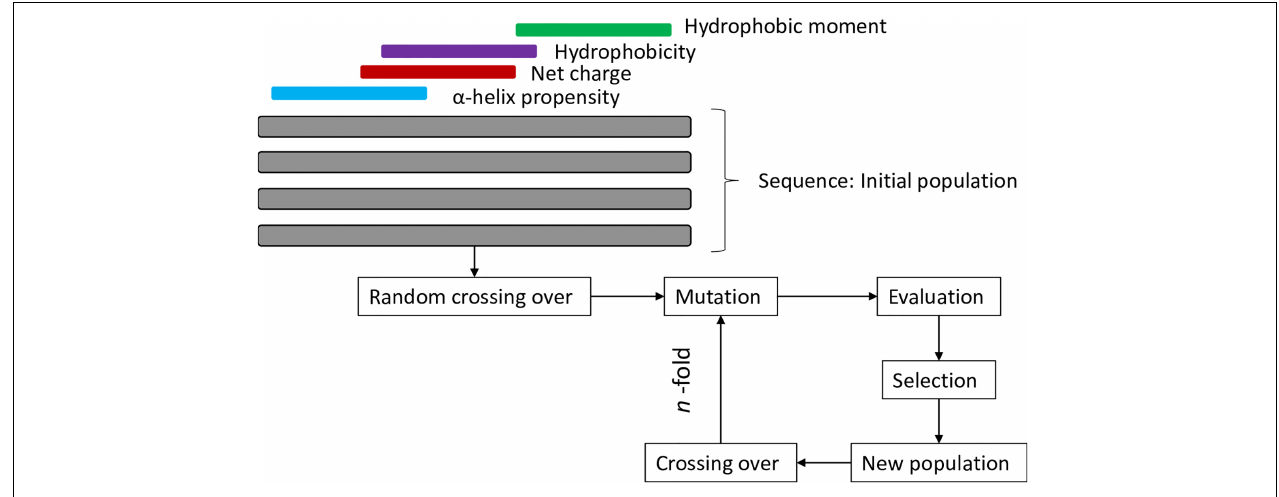
FIGURE 2 | Flowchart of genetic algorithm of Porto et al.